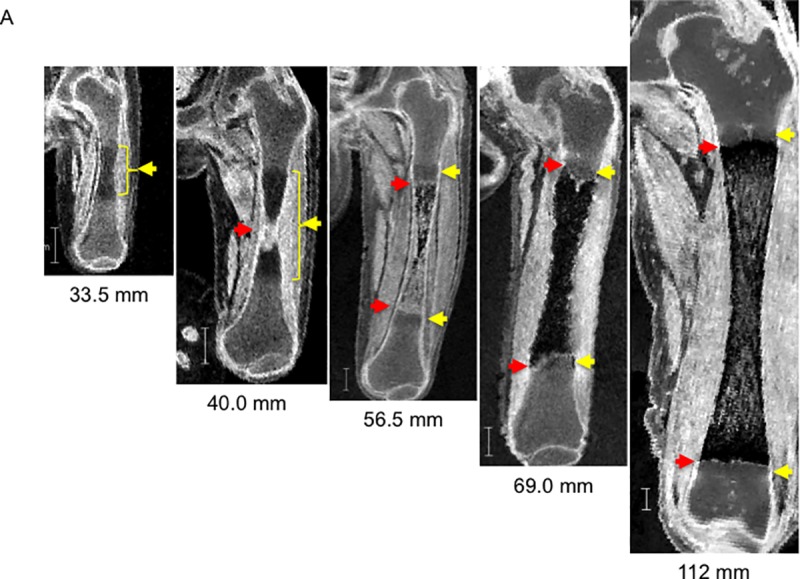
Representative cross-sectional view of the right femur during the early fetal period on 7-T MR image.The crown–rump length (CRL) of each fetus is indicated below the images. Yellow arrow: phase 4; red arrow: phase 5 according to Streeter’s classification. The region between the yellow arrows at the diaphysis corresponds to phase OS. The region outside the yellow arrows corresponds to phases 1–3.